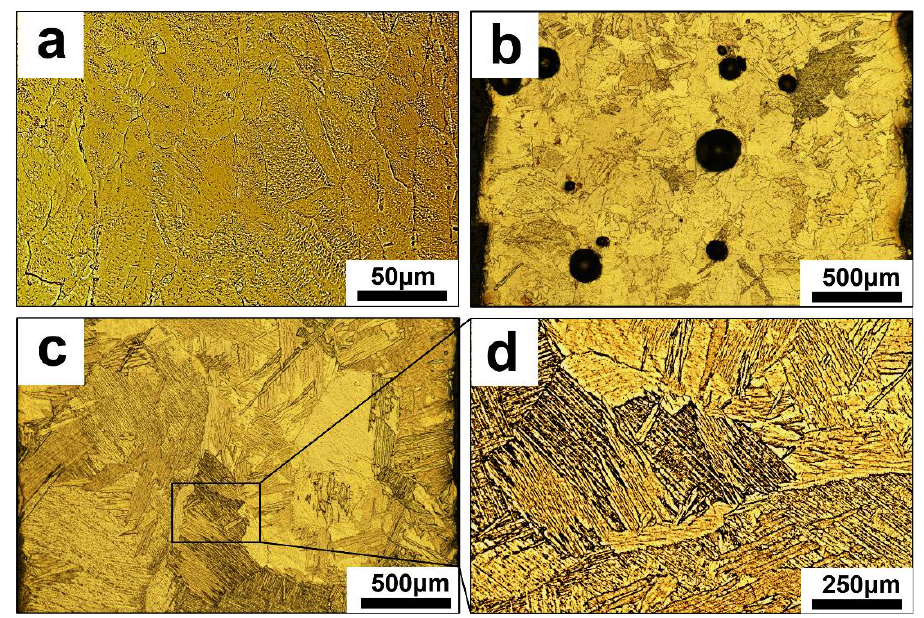
Figure 5. The optical microscope of CP-Ti using different prepared methods: ( a ) cast, ( b ) LDED-HDH titanium, ( c ) LDED-HDH-RF titanium, ( d ) zoom-in image of the square in LDED-HDH-RF titanium.